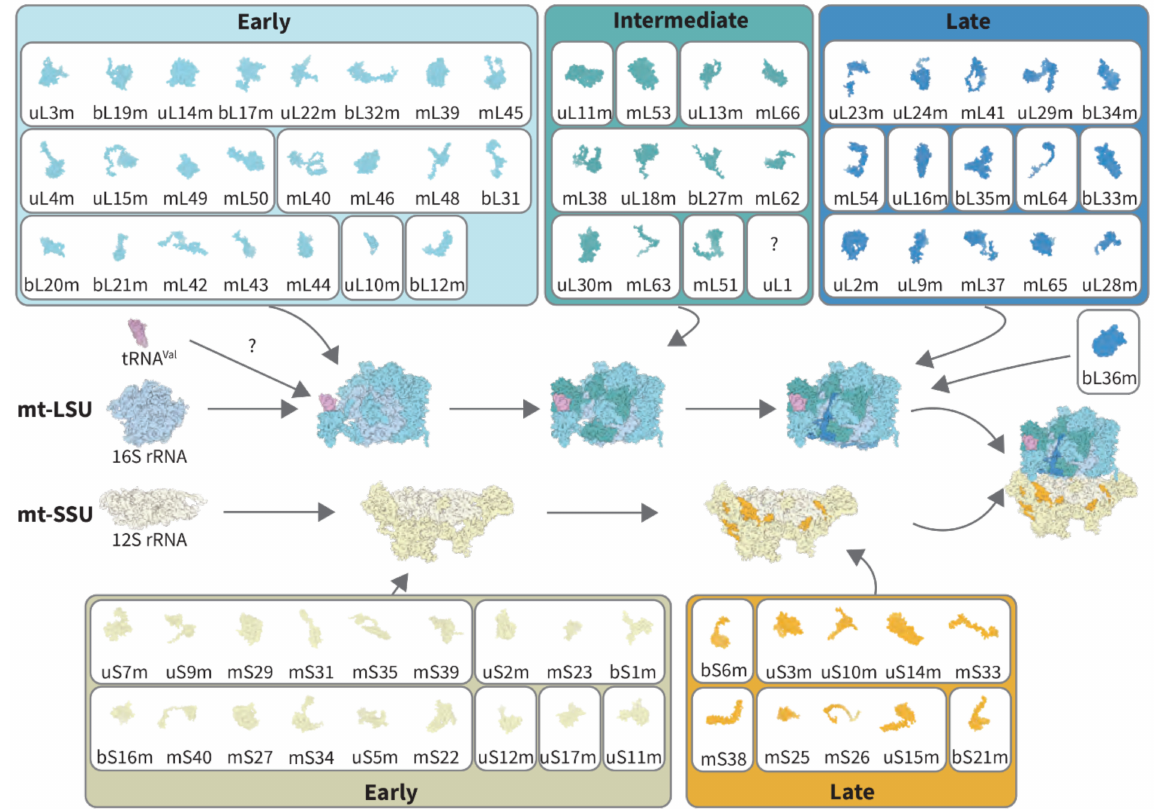
Figure 2. The assembly pathways of mt-LSU and mt-SSU. Components of the mt-LSU and mt-SSU are assembled in a hierarchical manner. The mt-LSU is assembled from 52 proteins, 16S rRNA, and mt-tRNA Val , whereas the mt-SSU is assembled from 30 proteins and 12S rRNA. Three main stages (early, intermediate, and late stages) have been identified in the mt-LSU, and two main stages (early and late stages) in the mt-SSU assembly pathways. Protein components integrating into the assembly intermediates in clusters are shown together, while individually recruited proteins are shown alone in boxes. Except for bL36m, the incorporation data are based on [16]. bL36m was integrated according to [17]. The timing of mt-tRNA Val incorporation is still unknown (marked by a question mark), as well as the incorporation of mL52, mS37, and bS18m. All structures are based on the model PDB 6ZSG [18]. uL1m is not included in the figure due to its absence in 6ZSG; for uL12m, only the N-terminal structure of uL12m is depicted as it is the only part resolved in the 6ZSG